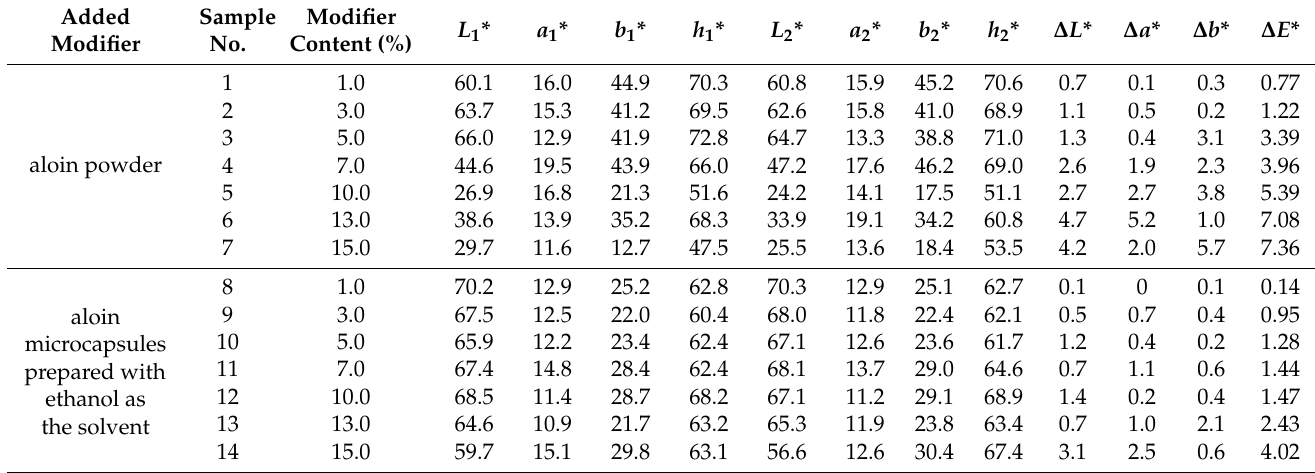
Table 2. Color difference measurement data of coating surface.